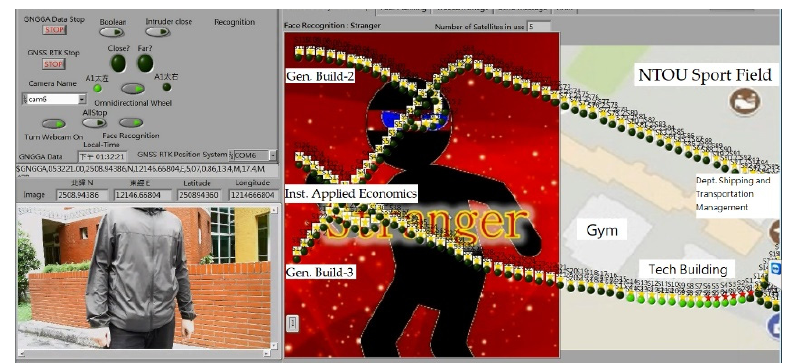
Figure 28. The robot identified the intruder as a stranger.